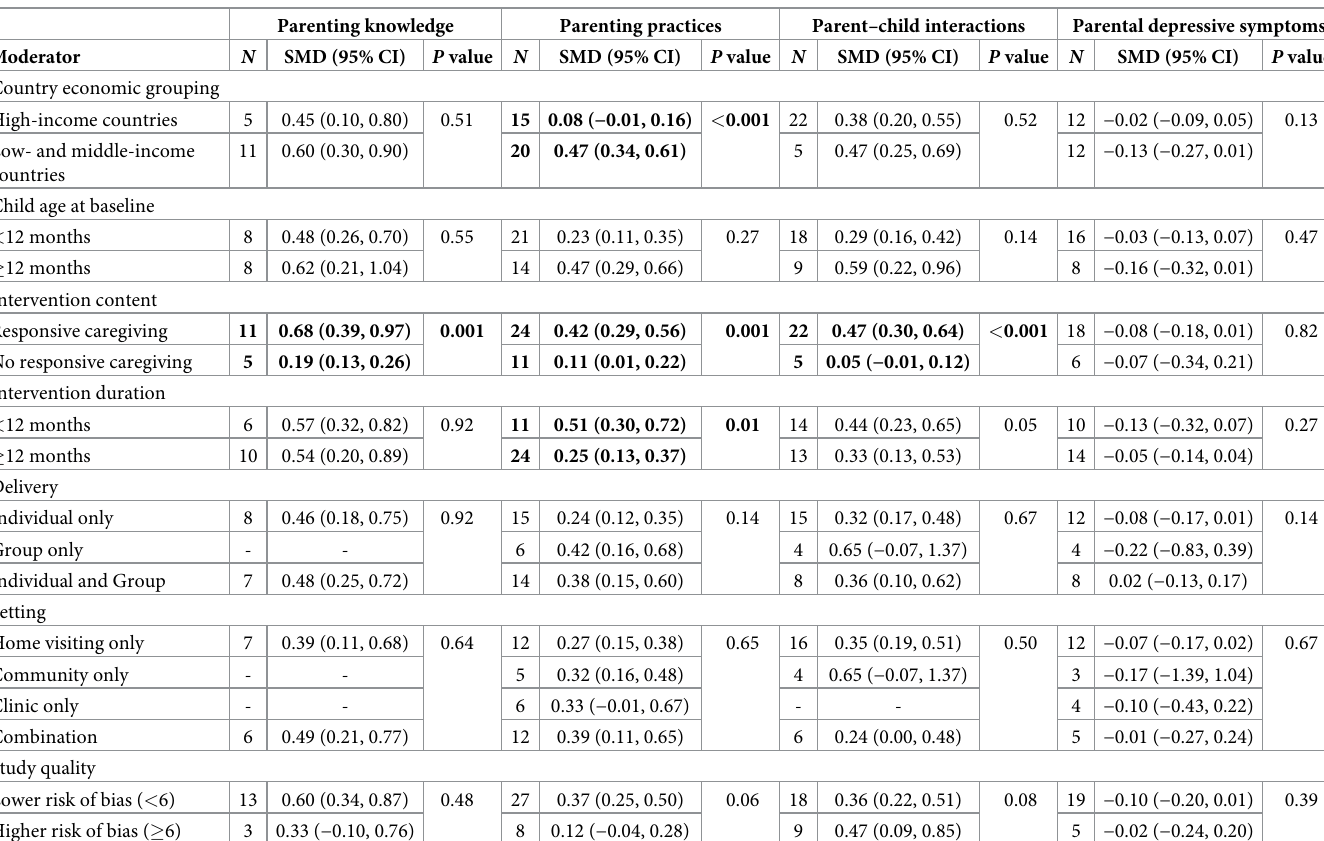
Table 3. Subgroup results for the effect of parenting interventions on parenting outcomes stratified by study